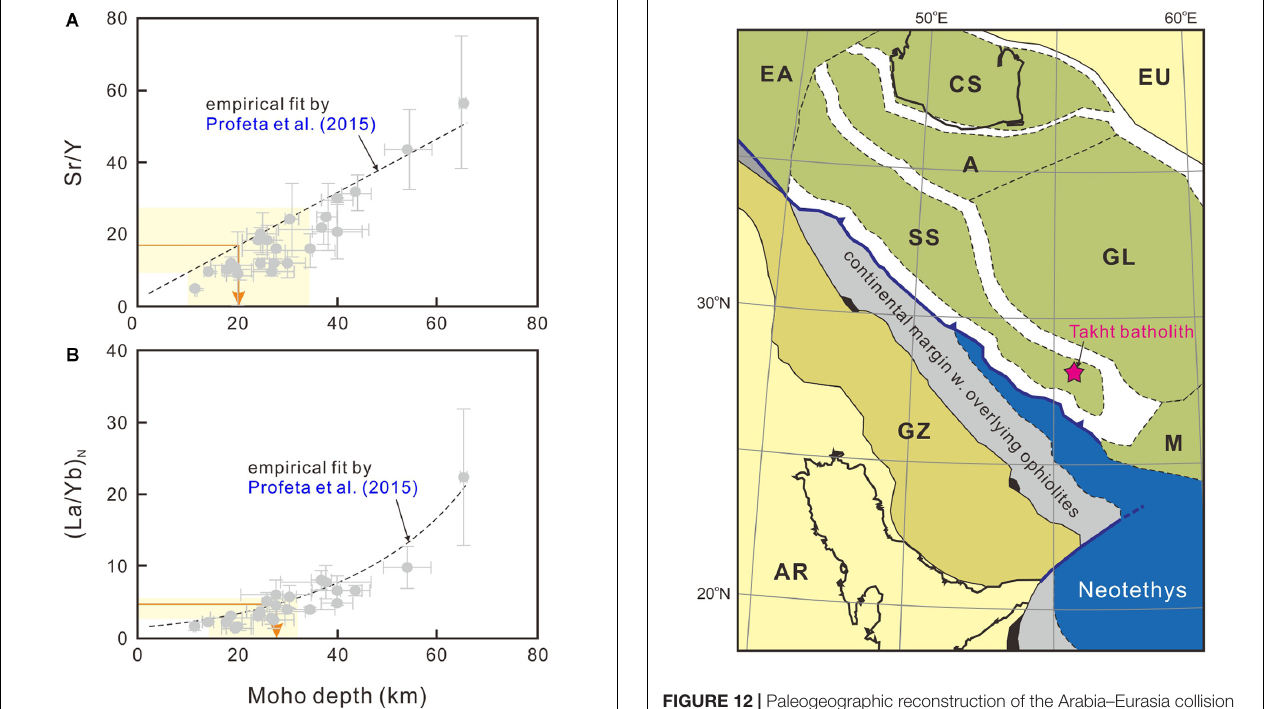
FIGURE 12 | Paleogeographic reconstruction of the Arabia–Eurasia collision zone at ∼ 27 Ma (McQuarrie and van Hinsbergen, 2013). Gray regions denote the northeastern margin of Arabia with overlying ophiolites (shown in black, including Kermanshah, Neyriz and Semail from north to south). White regions denote areas that were shortened among continental blocks situated between Eurasia and Arabia. Red star denotes the location where the Takht batholith might have formed. A = Alborz, AR = Arabia, EA = East Anatolia, EU = Eurasia, GL = Greater Lut, GZ = Greater Zagros, M = Makran, SC = South Caspian, SS =